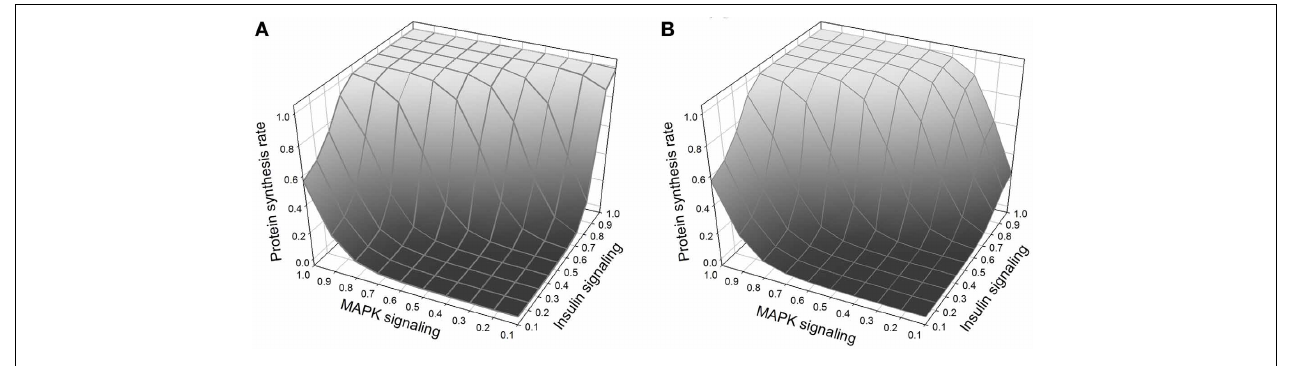
FIGURE 7 | (A) Protein synthesis as a function of MAPK and insulin. MAPK and insulin act synergistically, and the maximum protein synthesis occurs when both pathways are activated. Nevertheless, at low levels of MAPK signaling, insulin is still able to stimulate protein synthesis. (B) Same figure